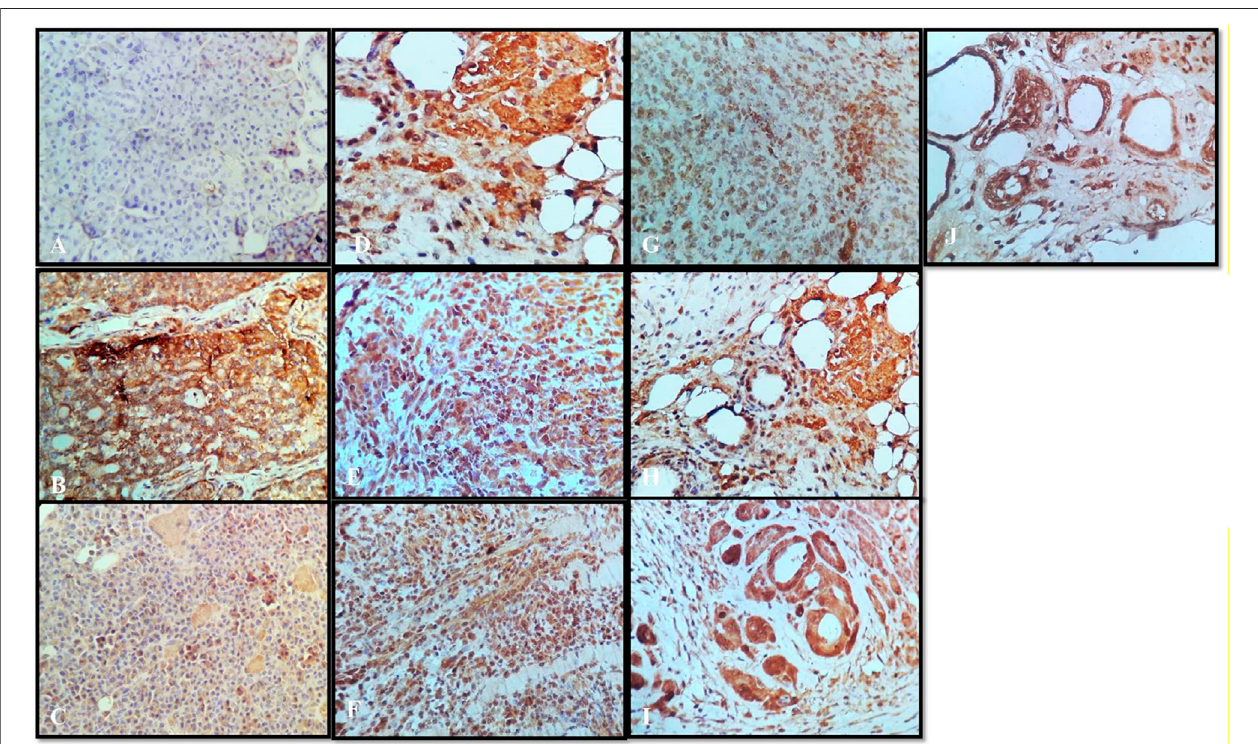
FIGURE 8 | Immunochemistry TNF- α : (A) normal control, (B) disease control, (C) marketed standard, (D) thymoquinone Std, (E) α -pinene Std, (F) β -pinene Std, (G) N. sativa extract, (H) N. sativa oil, (I) berberine Cl Std, and (J) Berberis aristata extract.